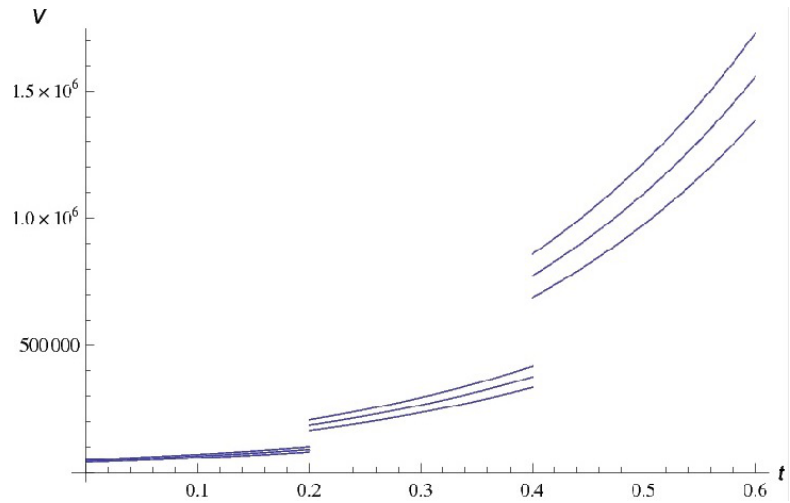
Figure 2. The solution of fuzzy differential-difference Equations (23) and (24) on the interval [ 0,0.6 ] with α =